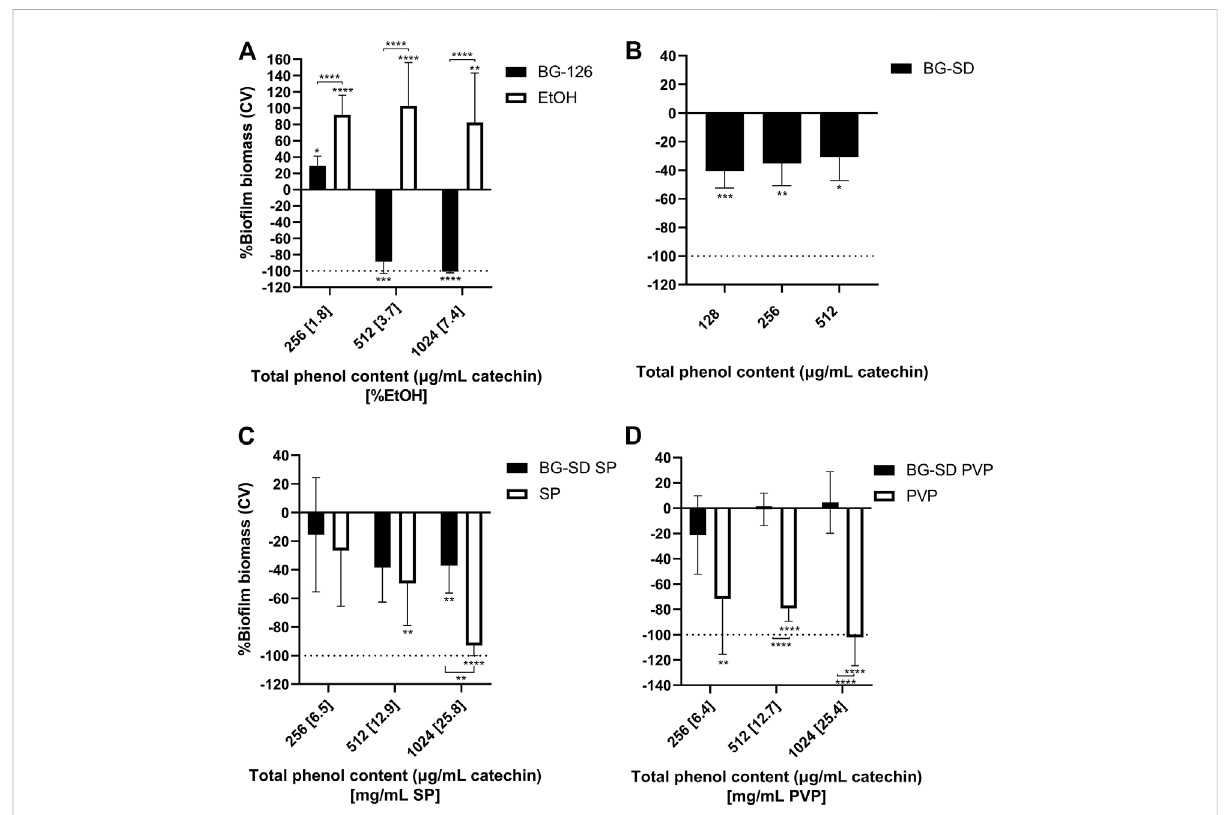
FIGURE 2 Effect of Buddleja globosa Hope (BG) extracts on Pseudomonas aeruginosa bio fi lm formation. P. aeruginosa was treated for 24 h with a hydroalcoholic BG extract (BG-126) (A) , spray-dried BG extract (BG-SD) (B) , spray-dried BG extract with Soluplus ® (BG-SD SP) (C) , and spray-dried BGextractwithPVP(BG-SDPVP) (D) werestainedwithcrystalviolet(CV)forthedeterminationofthebiomassofbio fi lmsbasedontheamountofCV retained by the stained wells. The results are expressed as changes in %biomass with respect to the control group. Asterisks on bars indicate a statistically signi fi cant difference with respect to the untreated control, and asterisks on brackets indicate differences between the BG formulations and the excipients. * p ˂ 0.05, ** p ˂ 0.01, *** p ˂ 0.01, and **** p ˂